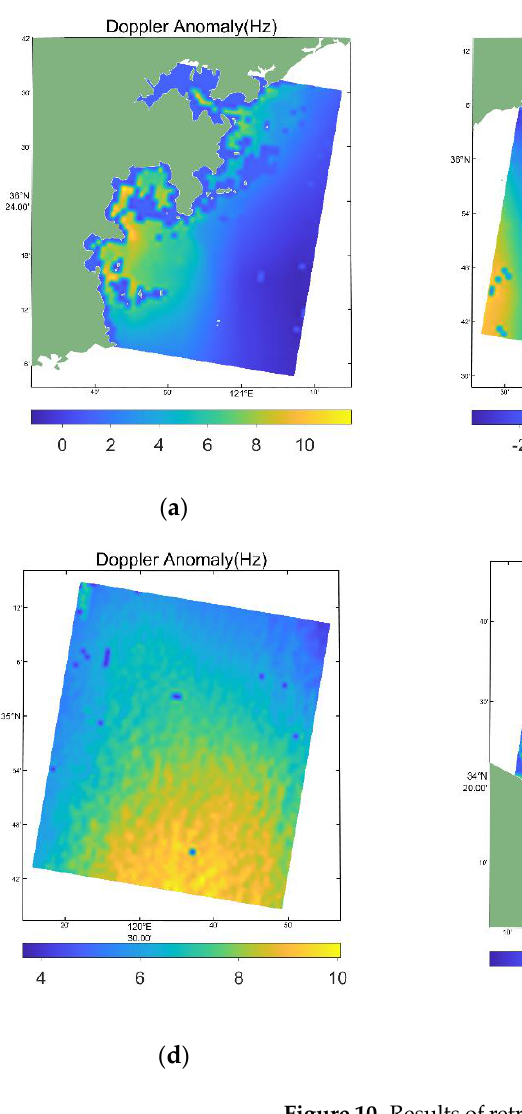
Figure 10. Results of retrieving the Doppler anomaly f DA using the CDOP model. ( a – e ) are retrieving the Doppler anomaly results by using the CDOP model from the five scenes in the Figure